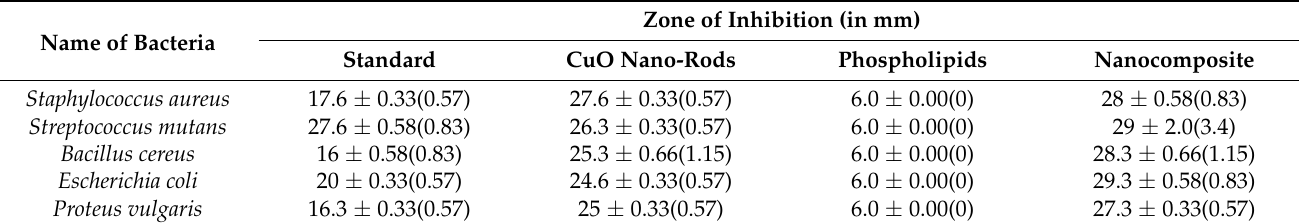
Figure 5. Antibacterial activity showing the zone of inhibition in E. coli (phospholipids showing negative activity while the nanocomposite represents the lysis zone). Table 3. Interpretation of the zone of inhibition results against various bacterial strains.